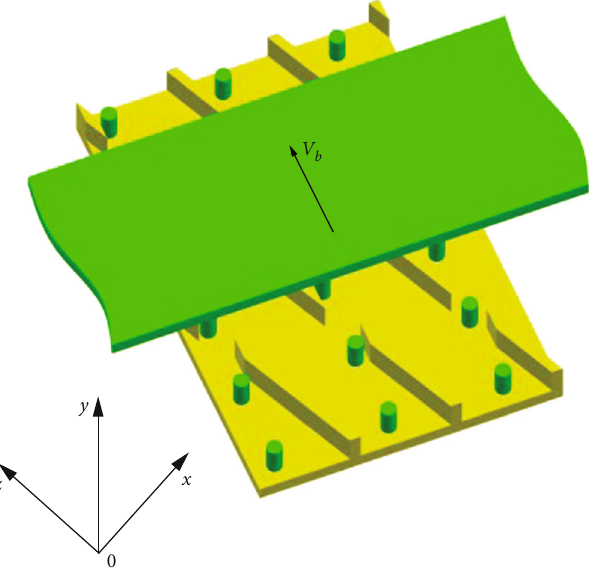
Figure 2: Flat plate model with a stationary screw and a moving barrel.